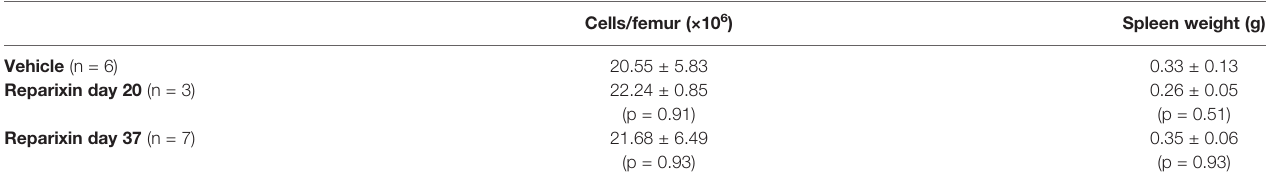
Data are presented as Mean (± SD) and p-values were calculated with respect to vehicles by Tukey ’ s multiple comparisons test.